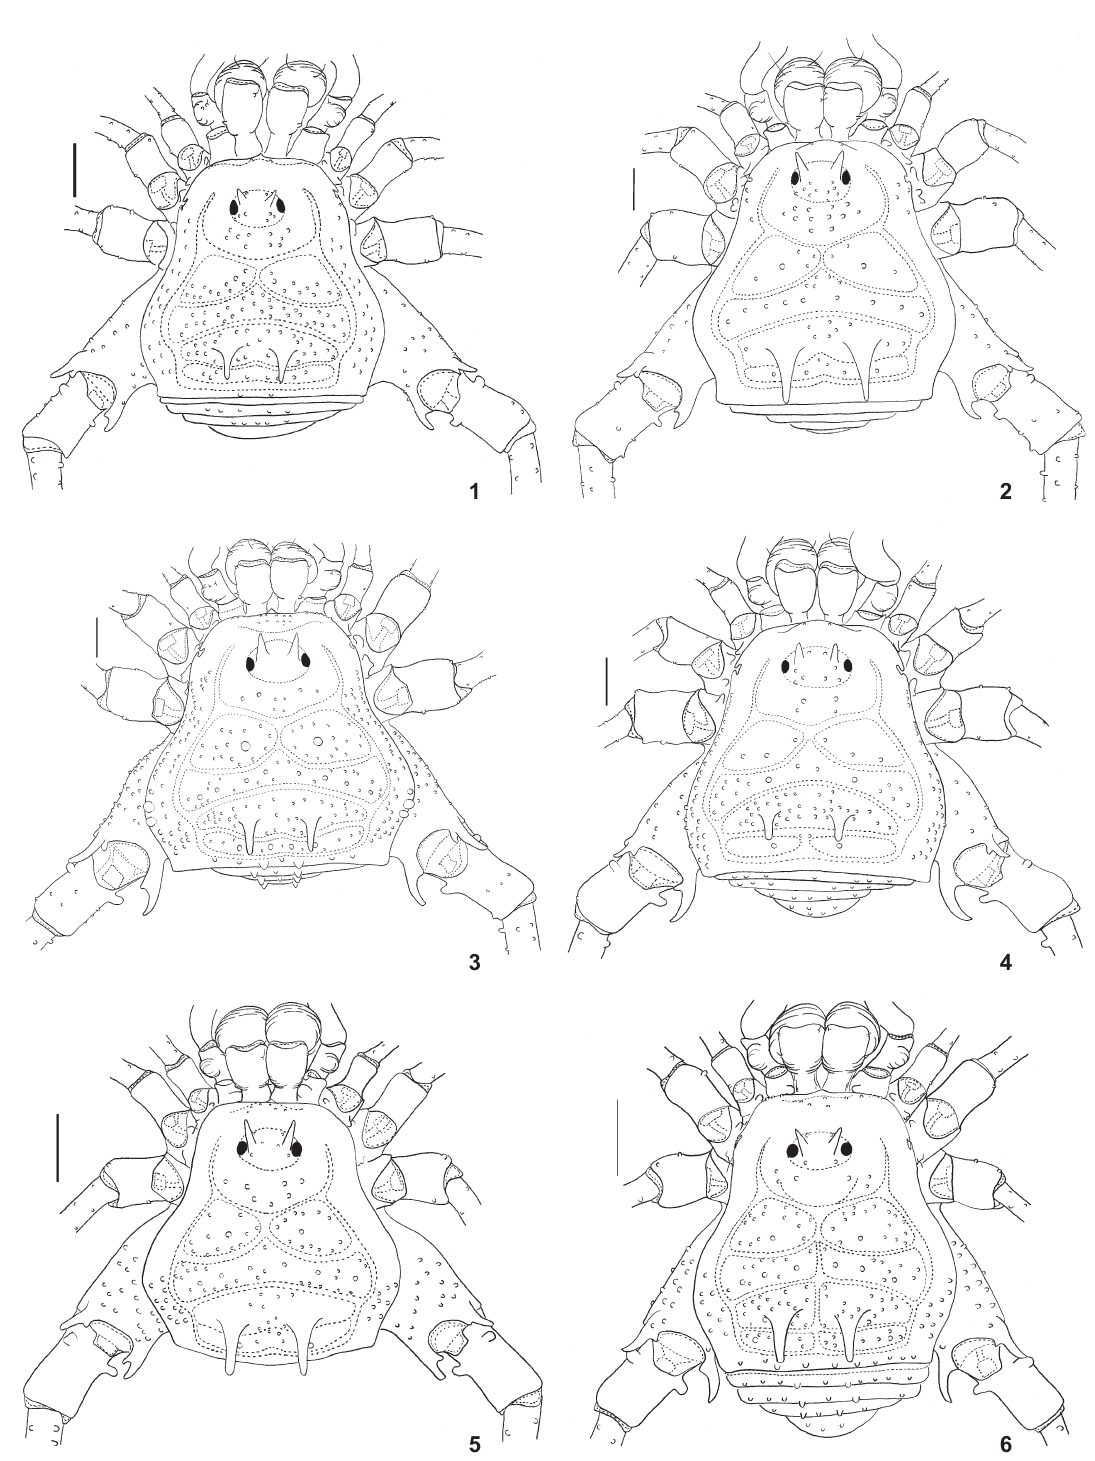
Figures 1-6. Dorsal view of Longiperna males: (1) L. cancellata (MZSP 27374); (2) L. concolor (MZSP 32412); (3) L. coxalis (IBSP 4810);